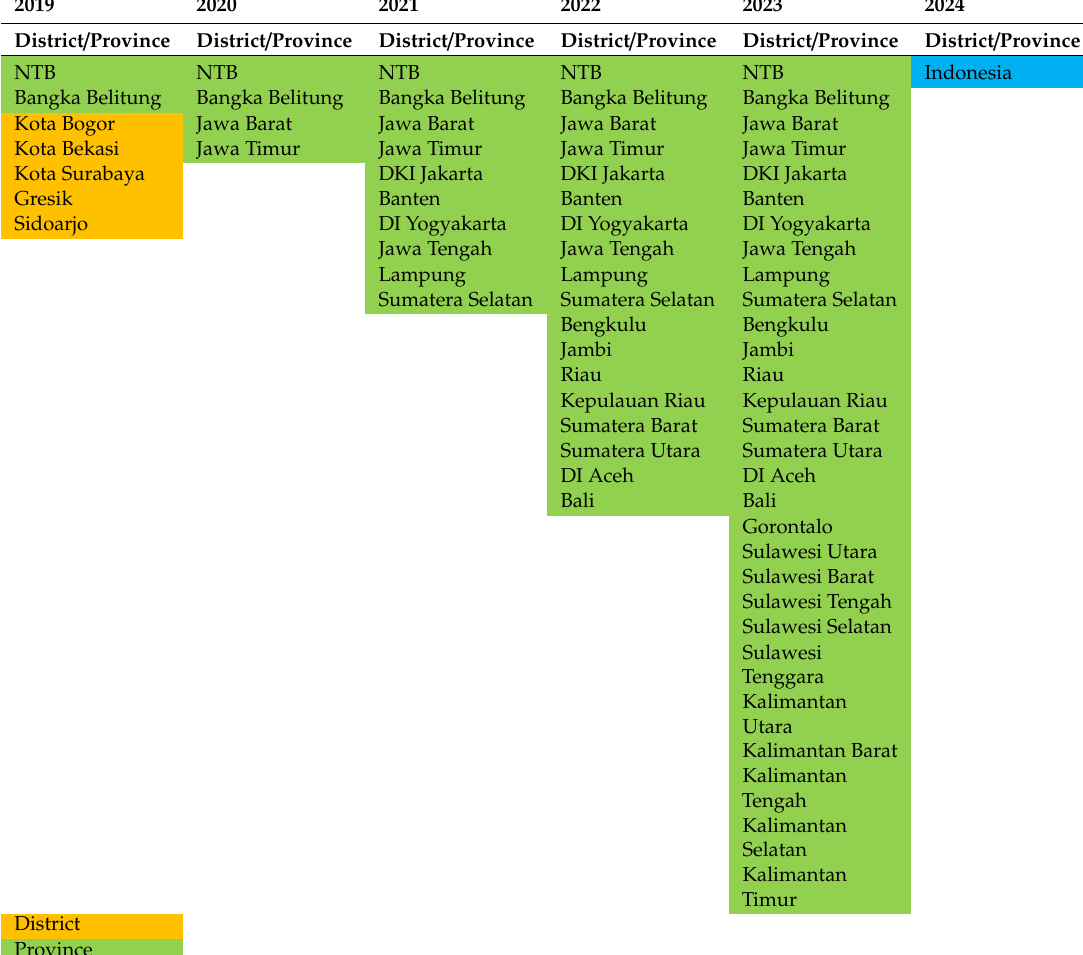
Table 3. Targeted area of PCV introduction in Indonesia. Yellow, green and blue are for district, province and national level, respectively.